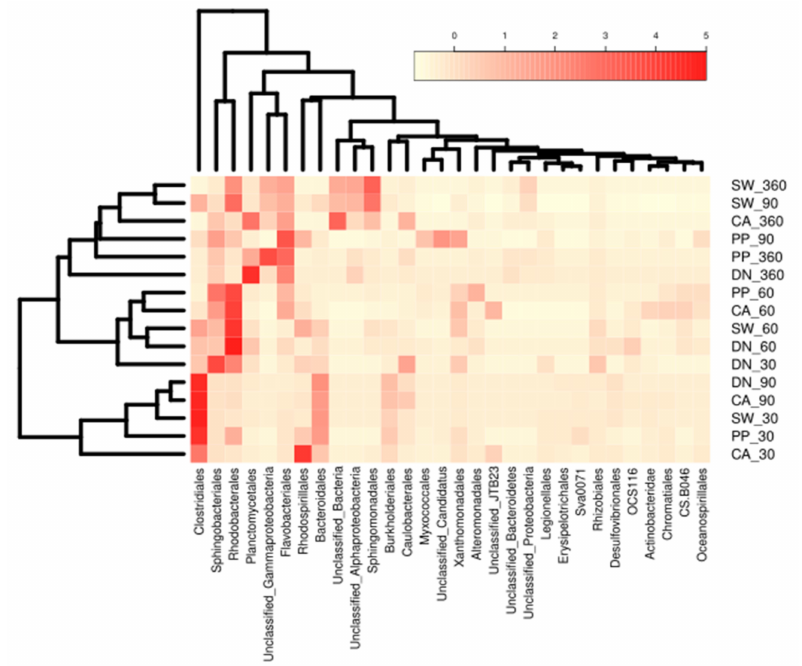
Figure 4. Heat map showing the bacterial orders (>5% of total abundance) at different time points and